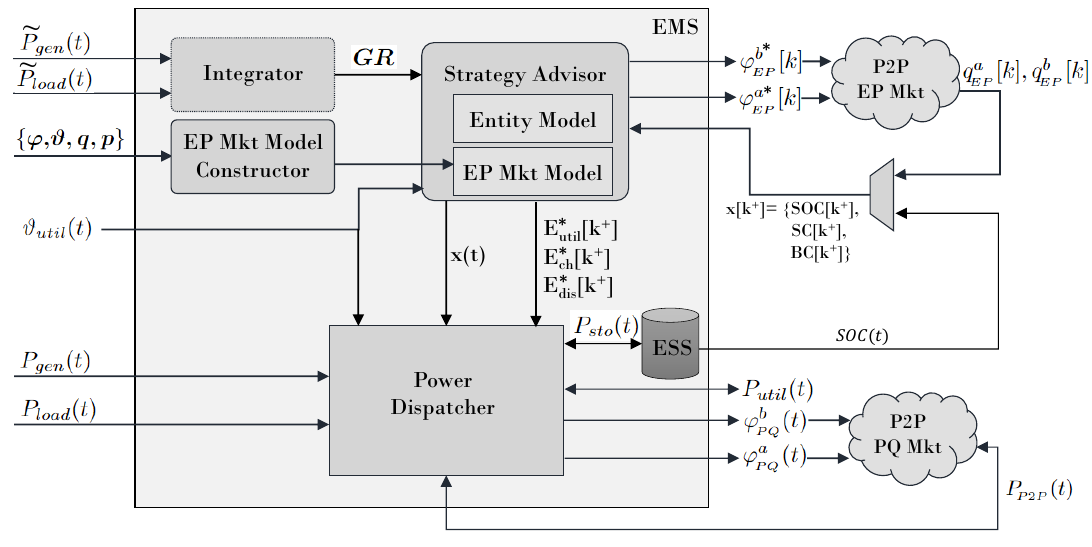
Figure 1. Structure of the proposed EMS, allowing the energy entity to participate simultaneously in two eP2P markets, one discrete in which packages are exchanged and another continuous in which power quotas are